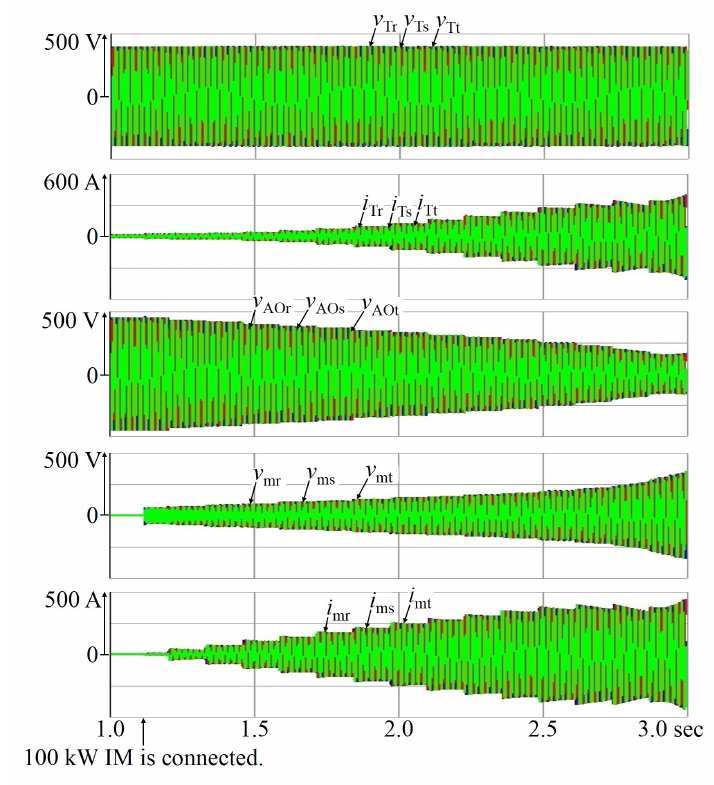
Figure 12. Simulation waveforms for 2 s when the proposed inrush current suppressor is connected to the 100-kW